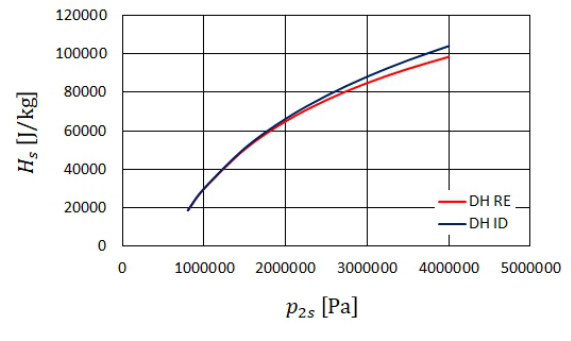
Figure 5. Ideal gas isentropic work ∆ H from Eq. (43) – blue curve and real gas isentropic work ∆ H s – red curve. Inlet conditions propane p 1 = 550000 Pa, T 1 = 293 . 15